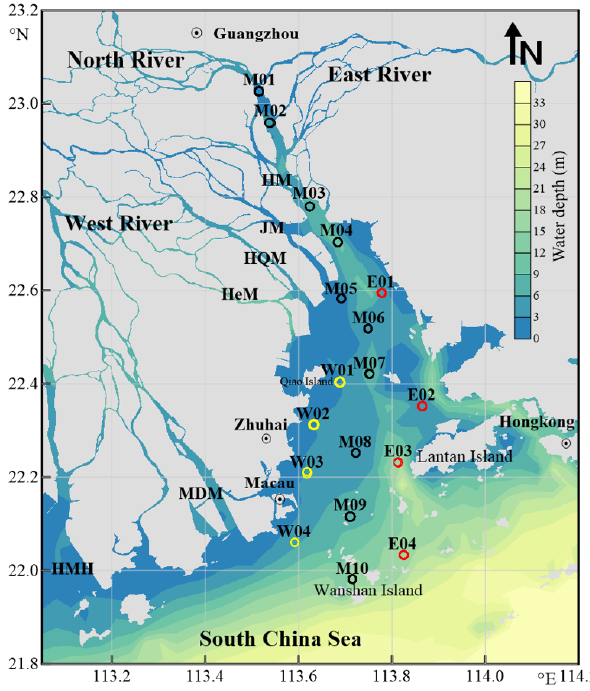
Figure 1. Map of sampling stations in the Pearl River Estuary. Sta- tion names starting with letters M, W, and E designate the main, west, and east transects, respectively. See Table S1 for